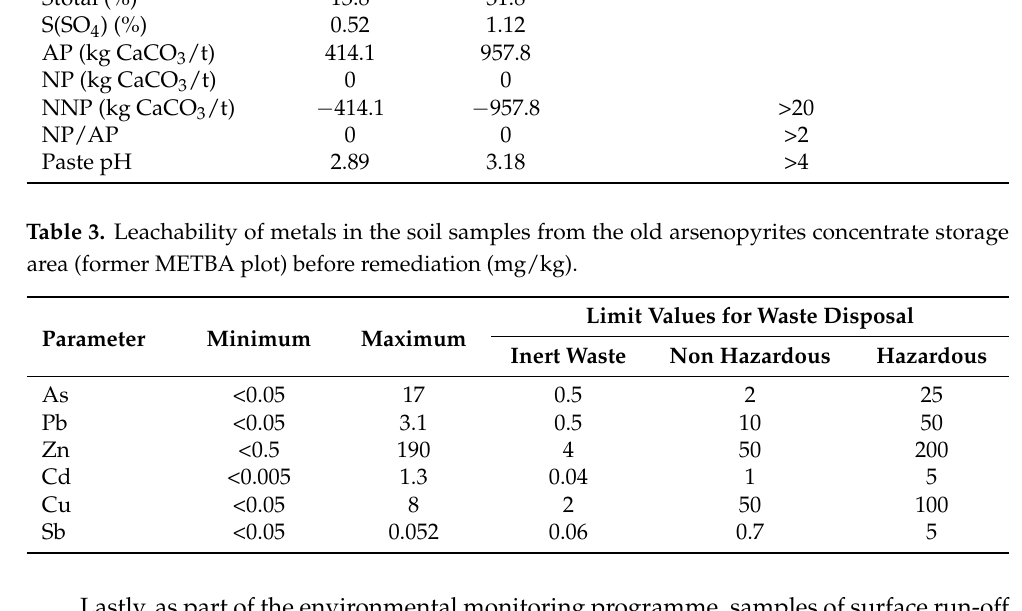
Table 1. Heavy metal content of surface soil samples from the old arsenopyrites concentrate storage area (former METBA plot) before remediation (mg/kg) .